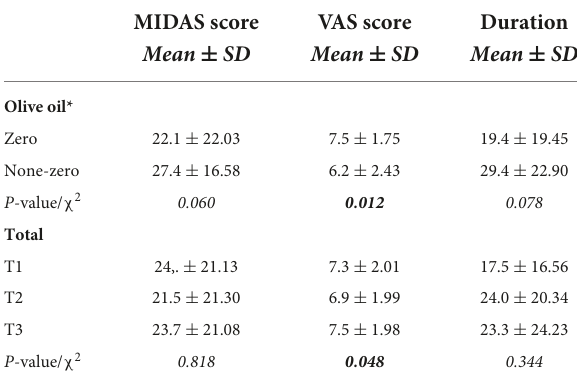
TABLE 2 Migraine attack duration, severity, and disability according to participants’ polyphenol